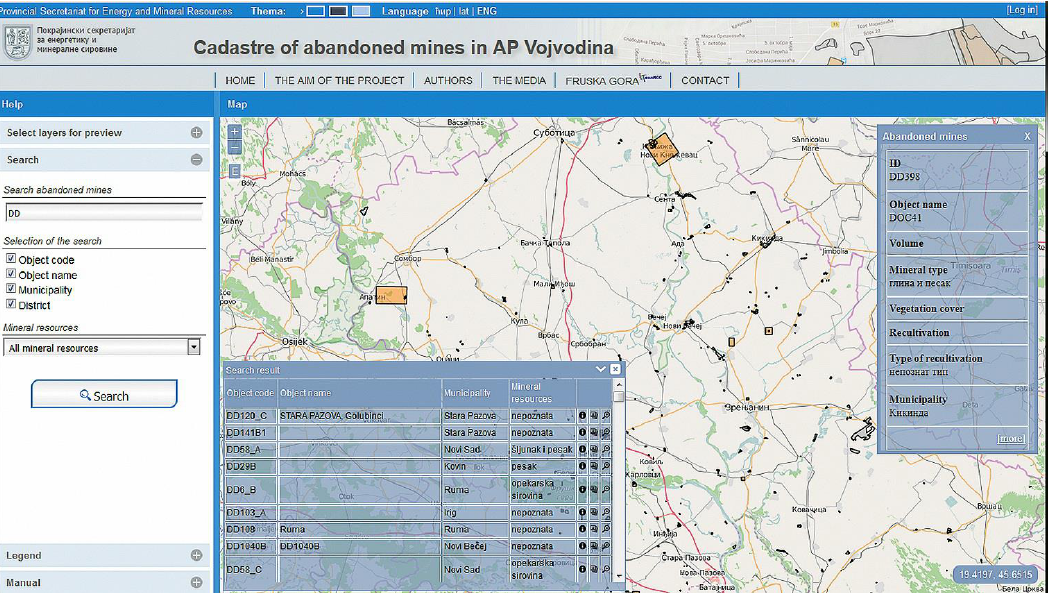
Figure 1. Main page of the Cadastre of Abandoned Mines of Vojvodina.